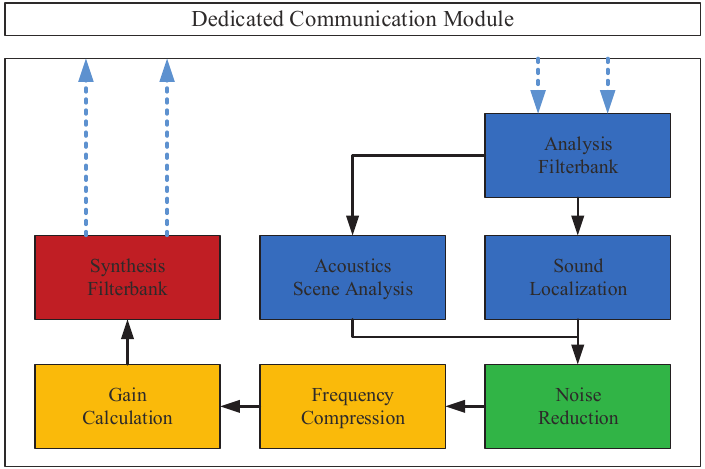
Figure 8. Block diagram of the real-time